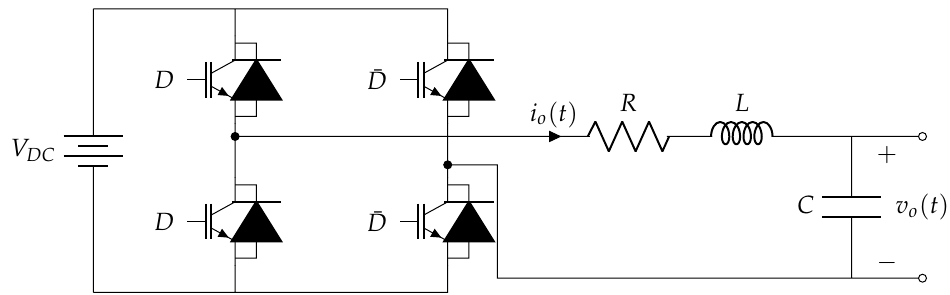
Figure 4. Full bridge inverter connected to an LC filter and a resistive load [31].